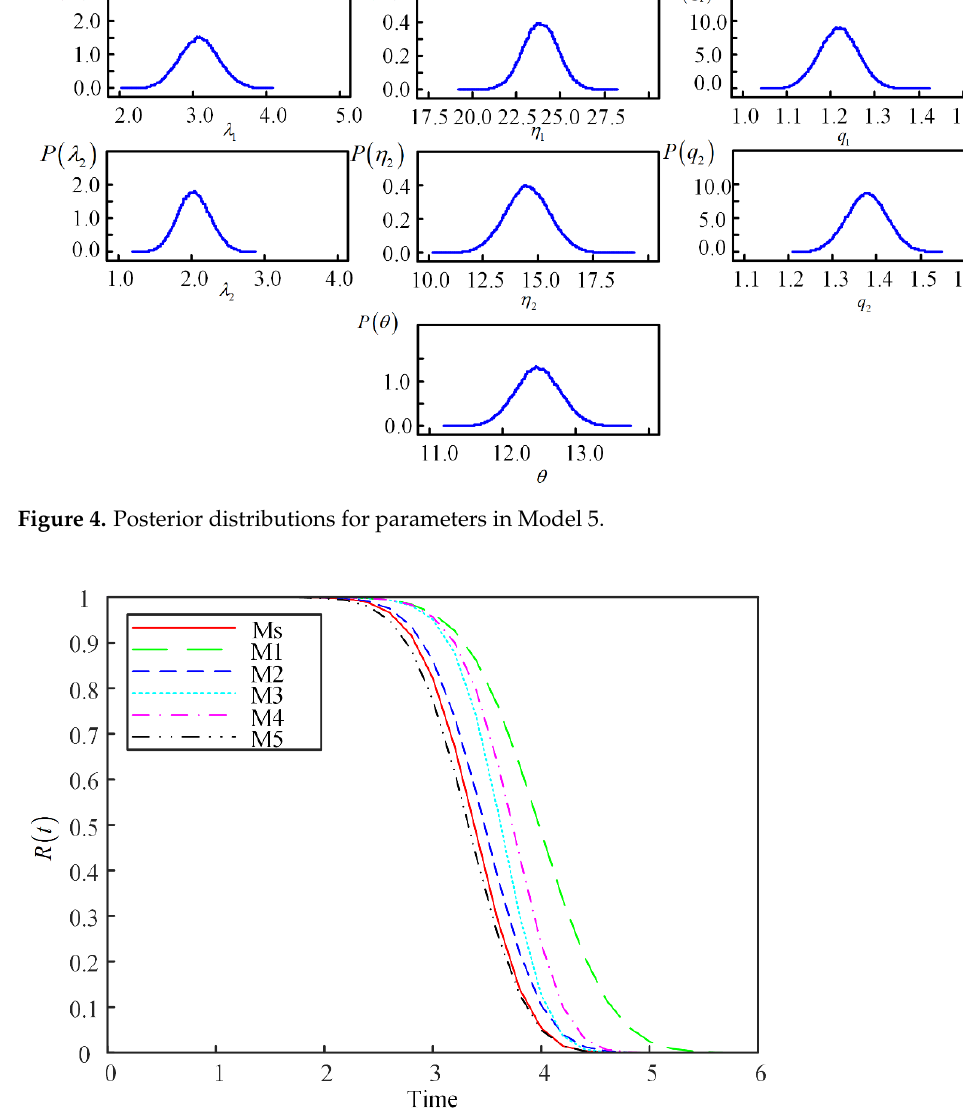
Figure 4. Posterior distributions for parameters in Model 5.